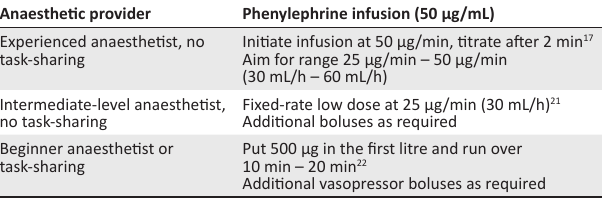
TABLE 1: Suggested vasopressor management of spinal